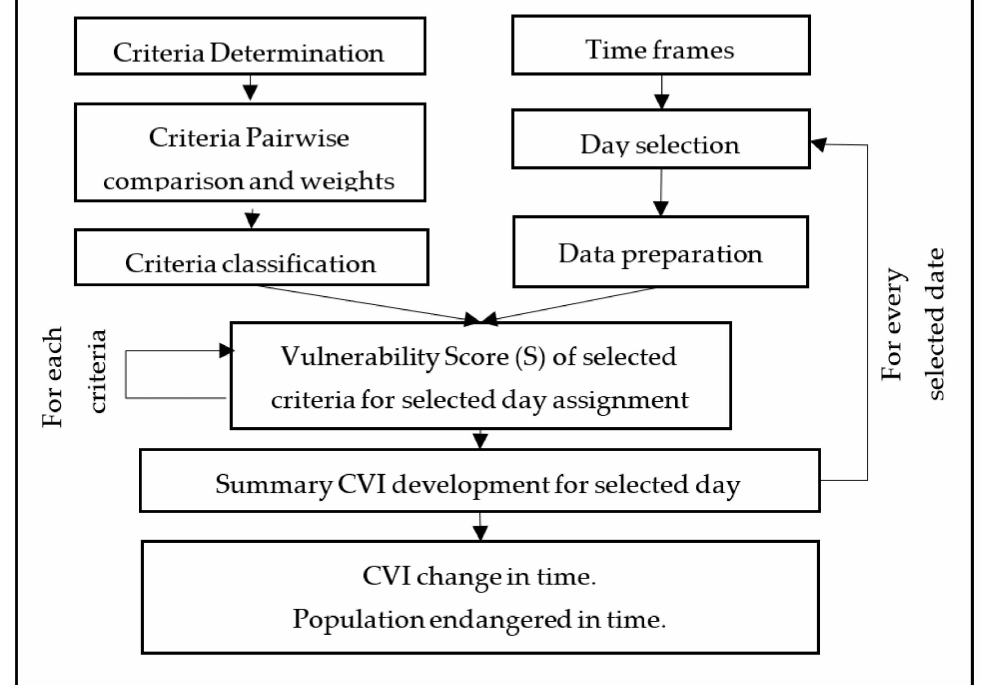
Figure 3. The methodology of spatiotemporal index estimation performed in research (own study). AHP methodology allows for the importance estimation by calculating the weight of selected criteria by means of pairwise comparisons of each evaluation